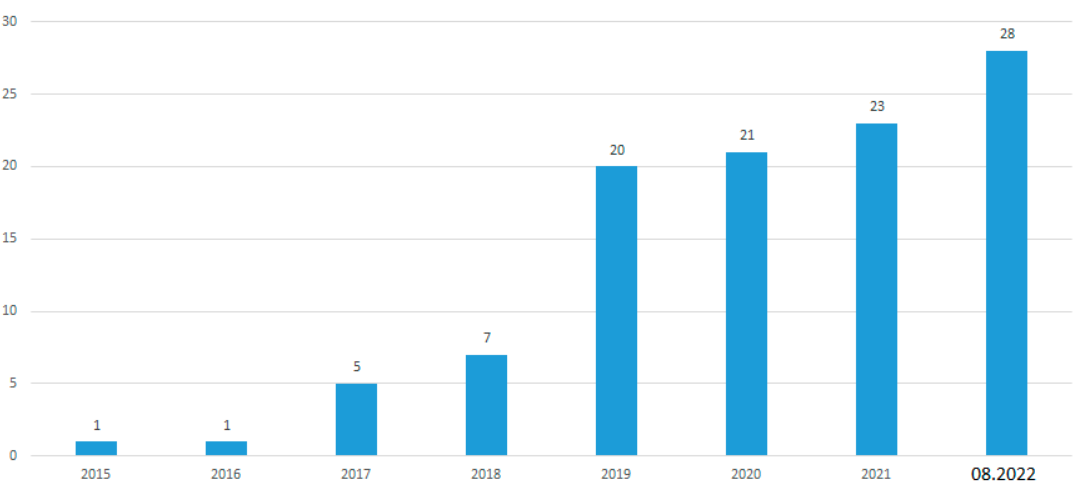
Figure 1. The number of scientific publications over the years—the Industry 4.0 keyword. Source: own study.